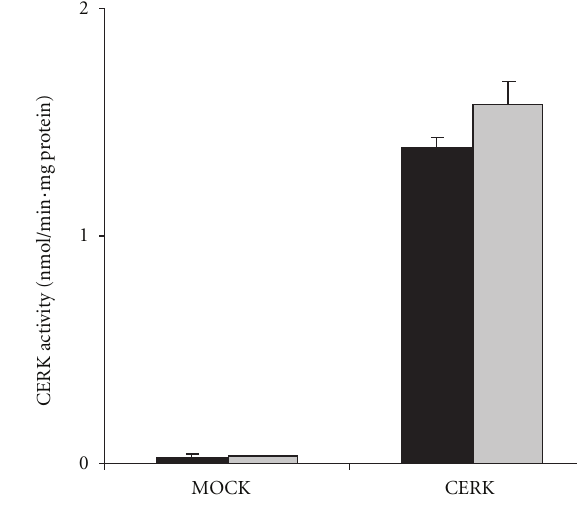
Figure 5: CERK activity in cultured cells. CERK activity towards NBD-C 6 -Cer was determined in lysates from CHO cells, transfected with pCMV-Tag2B (mock) or pHVO001, coding for a Flag- HsCERK fusion [8], using the fluorescence assay (black bars) or the radiometric assay (grey bars, mean ± SEM, n = 3). CERK activity is expressed as nmol per mg protein per min (nmol/min · mg